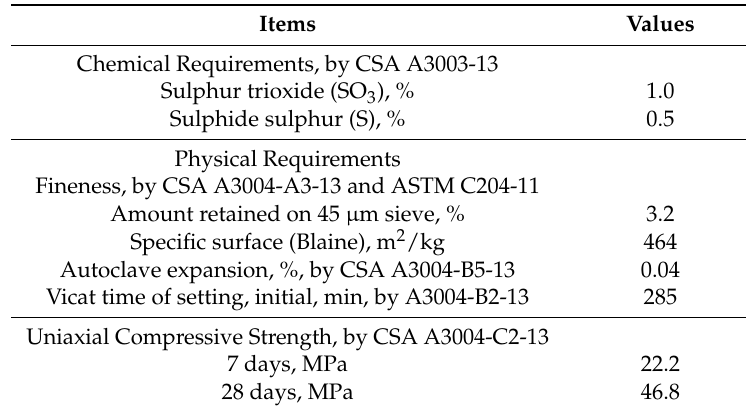
Table 3. The characteristic parameters of the final blended